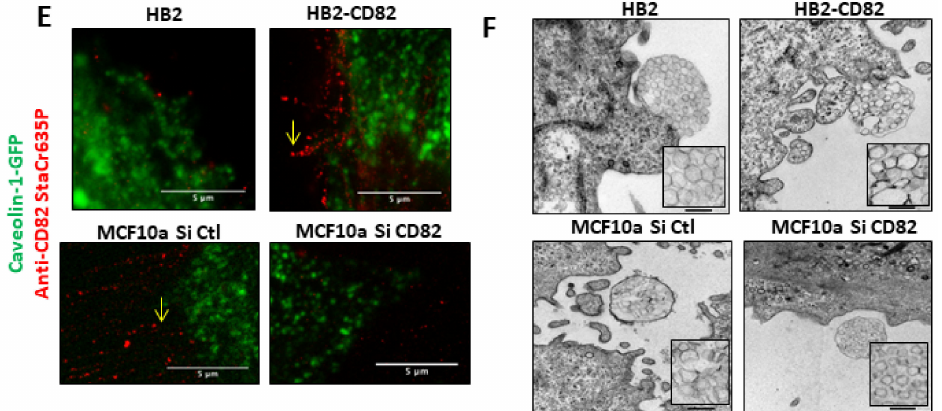
Figure 3. CD82 regulates membrane tension and the presence of cell surface caveolae in HB2 and MCF10a cells. ( A ) Schematic view of the membrane tether pulling experiment. The approach and retract curves are, respectively, in red and blue. Step 1 corresponds to the tip indenting the cell membrane, Step 2 to the pulling of the membrane tube during retraction and Step 3 to non-contact between the tip and the membrane. The blue rectangle highlights the rupture event between the tube and the tip where the rupture force is measured. ( B ) Rupture force of plasma membrane tubes as a read out of membrane tension in HB2 (110 measurements, 8 different probes, 21 cells, n = 8) and HB2-CD82 cells (119 measurements, 8 different probes, 19 cells, n = 8) and in MCF10a cells transfected with control siRNA (Si Ctl, 61 measurements, 2 different probes, 7 cells, n = 3) or with siRNA targeting CD82 (Si CD82, 60 measurements, 2 different probes, 8 cells, n = 3); ** p < 0.01. ( C ) TEM microscopy images of membranes of HB2 (upper), HB2-CD82 (middle), MCF10a cells transfected with siRNA control (lower left) or with siRNA targeting CD82 (lower right). Arrows indicate open-neck caveolae; * indicate rosettes; bar = 500 nm. ( D ) Quantification of the number of open-neck caveolae observed by EM and expressed per micrometer of membrane. **** p < 0.0001; ( E ) Fluorescent images of CD82 (STED) and Caveolin-GFP (confocal) in HB2 (upper, left), HB2-CD82 (upper right), MCF10a si Ctl (lower left) and MCF10a si CD82 (lower, right) cells. The yellow arrow points out CD82 in a membrane extension in HB2-CD82 cells and MCF10a si Ctl. ( F ) TEM microscopy images of migrasomes in HB2, HB2-CD82, MCF10a si Ctl and MCF10a siCD82 (bar = 500 nm); inserts enlighten vesicles inside